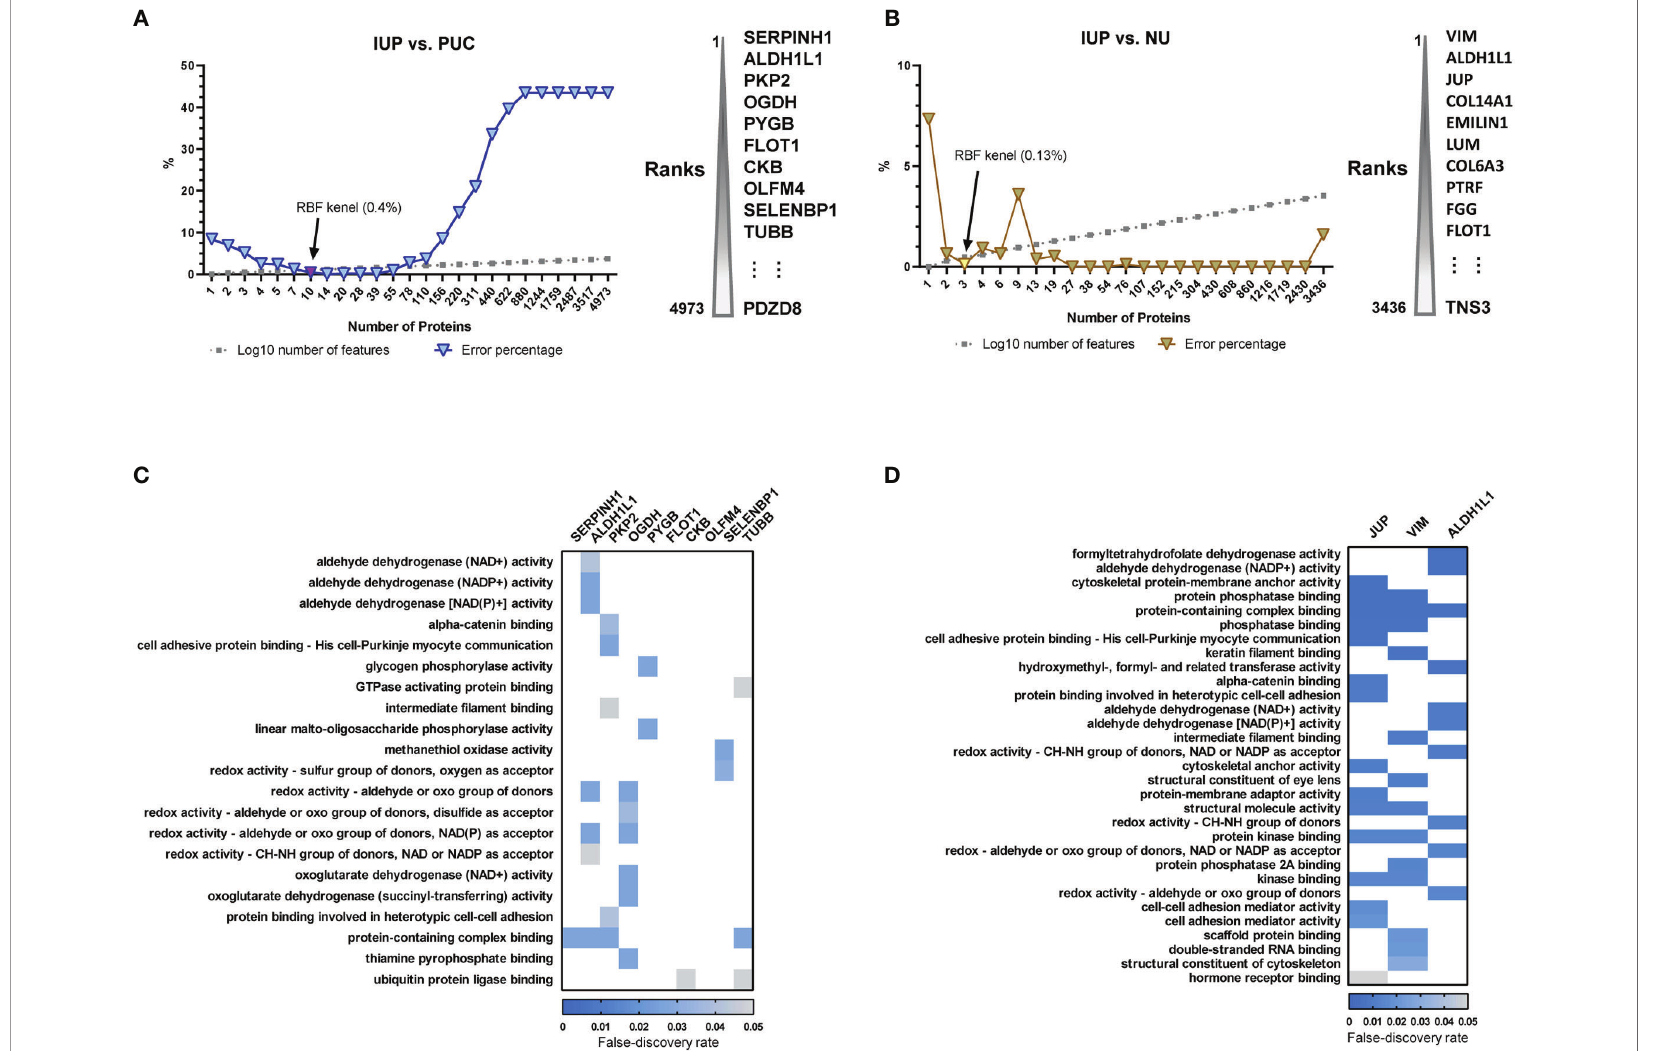
FIGURE 3 | Biomarker discovery of inverted urothelial papilloma (IUP) diagnosis. (A) The 10 optimal biomarkers of IUP vs. papillary urothelial carcinoma (PUC), identi fi ed by a support vector machine. (B) The three optimal biomarkers of IUP vs. normal urothelium (NU) identi fi ed by a support vector machine. (C) Gene Ontology-Molecular Functions (GOMFs) enriched in the 10 optimal biomarkers of IUP vs. PUC. (D) GOMFs enriched in the three optimal biomarkers of IUP vs.